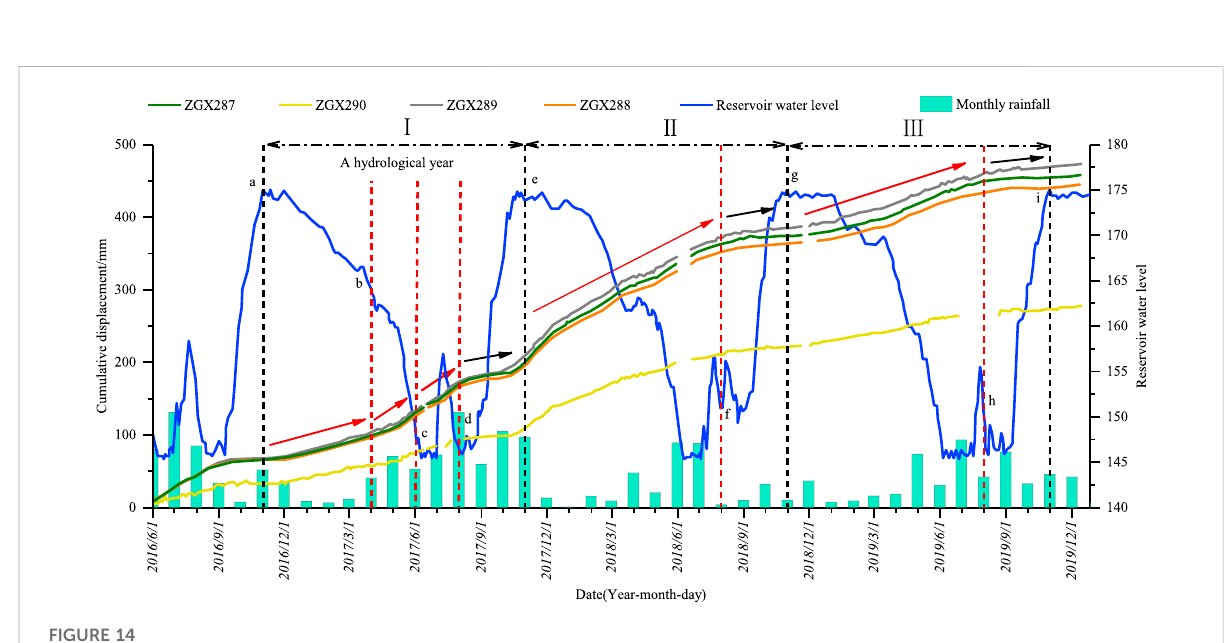
FIGURE 14 Cumulative displacement-time curve of Tanjiahe landslide automatic GPS monitoring